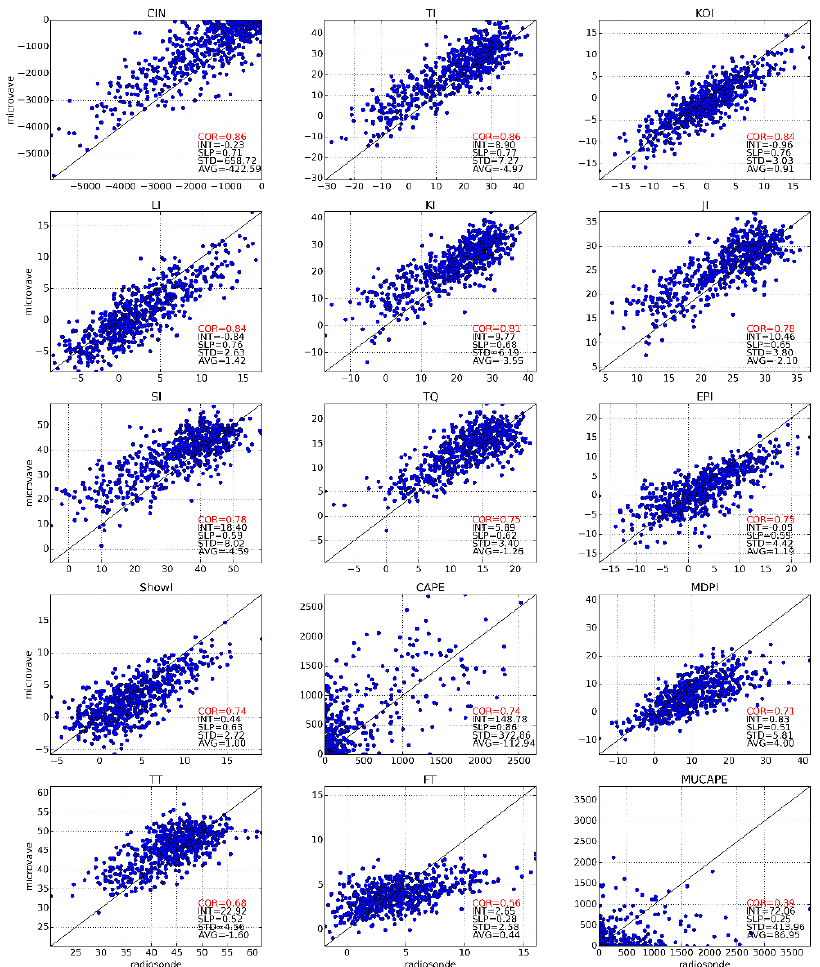
Figure 3. Scatter plots of the values of microwave and radiosonde indices with respective statistics: correlation coefficient (COR), slope (SLP) and intercept (INT) of a least-square linear fit; average (AVG) and standard deviation (STD) differences. AVG, STD, and INT are in units of the corresponding index. SLP and COR are unitless. CIN, Convective Inhibition; TI, Thompson index; KOI, KO index; LI, Lifted Index; KI, K index; JI, Jefferson Index; SI, S index; TQ, TQ index; EPI, Equivalent Potential Instability; ShowI, Showalter Index; CAPE, Convective Available Potential Energy; MDPI, Microburst Day Potential Index; TT, Total Totals index; FT, fog threat index; MUCAPE, Maximum Unstable CAPE.